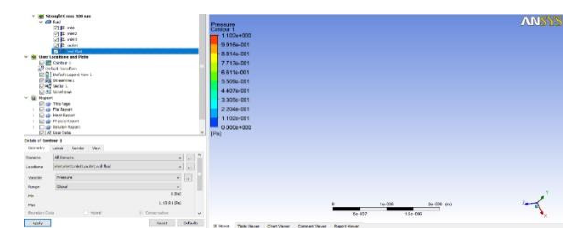
Fig. 9(d): Contour of Pressure obtained without channel diagram When we further increased radius and length in